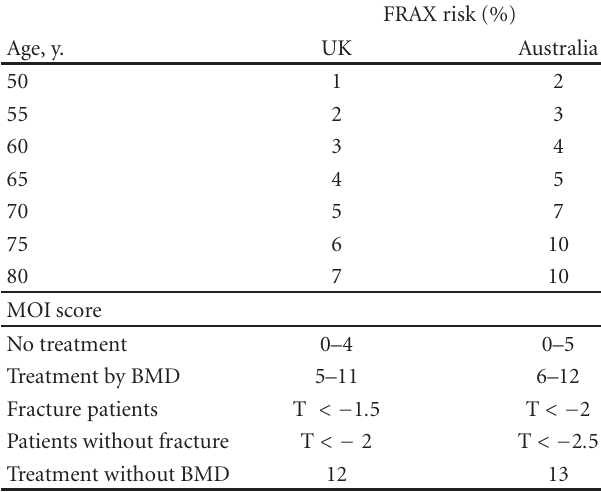
Table 4: Intervention thresholds by FRAX-BMD presented for UK and Australia (smoothed 10-year hip fracture probabilities, %) and the corresponding MOI thresholds, used for diagnostic comparison.